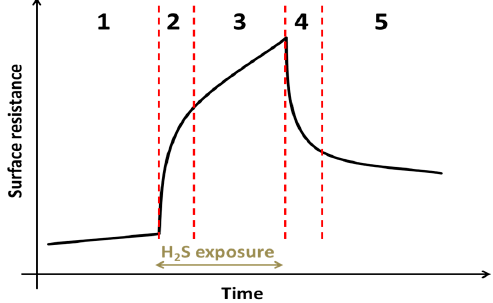
Figure 11. Schematic sketch of the surface resistance development of a GDC model composite electrode in reducing atmospheres with time during a typical sulphur poisoning experiment. Region 1 : Only slow degradation of the surface resistance is observed, attributed to Si poisoning. Region 2 : Upon the start of sulphur poisoning a fast increase of the polarisation resistance happens, which is most likely explained by surface adsorption of H 2 S and corresponding inhibition of the GDCs electrochemical active surface. Region 3 : Further decrease of the resistance potentially caused by adsorbed sulphur being incorporated into the GDC bulk. Region 4 : The sulphur supply is switched off and desorption of sulphur partly recovers the GDC surface. Region 5 : Slow recovery of the surface resistance, possibly connected to removal of absorbed sulphur in the GDC